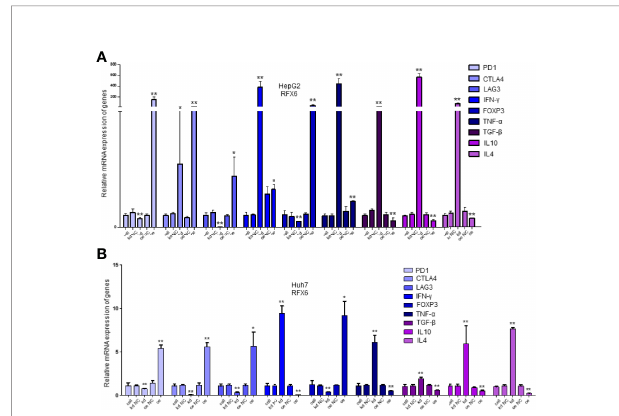
FIGURE 4 | Signi fi cantly expressed marker genes of immune cells under different RFX6 expression levels. (A) mRNA expression changes of immune cell receptor marker genes in HepG2. Data were represented as mean ± standard deviation (SD), n = 3, * p < 0.05, ** p < 0.01. (B) Relative expression of immune cell receptor mRNA in Huh7 after RFX6 alteration. Data were represented as mean ± standard deviation (SD), n = 3, * p < 0.05, ** p < 0.01.